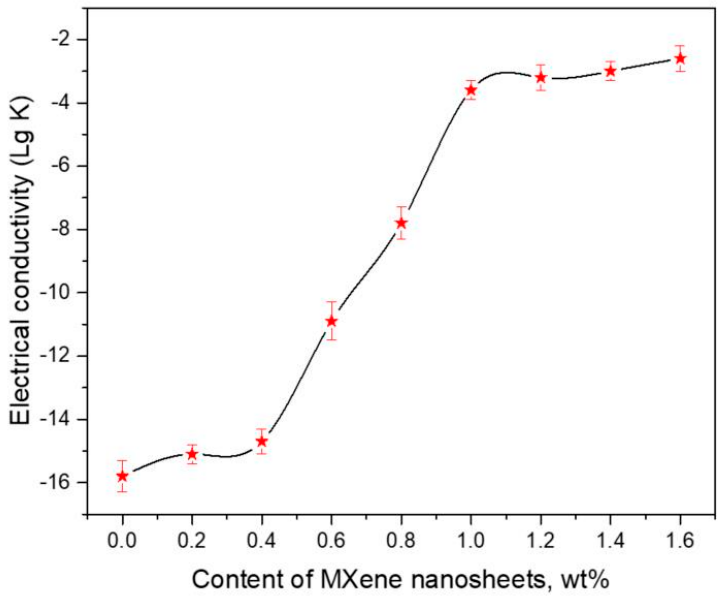
Figure 7. The electrical conductivity (K, S / m) of the EP / Ti 3 C 2 T x MXene nanosheets composite under various mass fractions of Ti 3 C 2 T x MXene nanosheets.